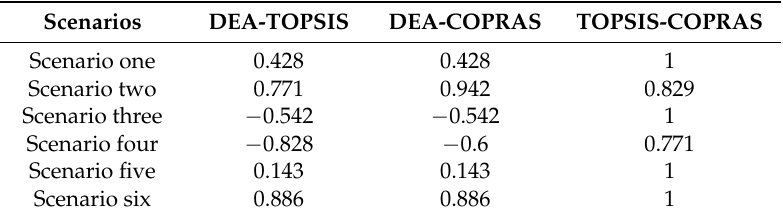
Table 10. Spearman correlation index of paired